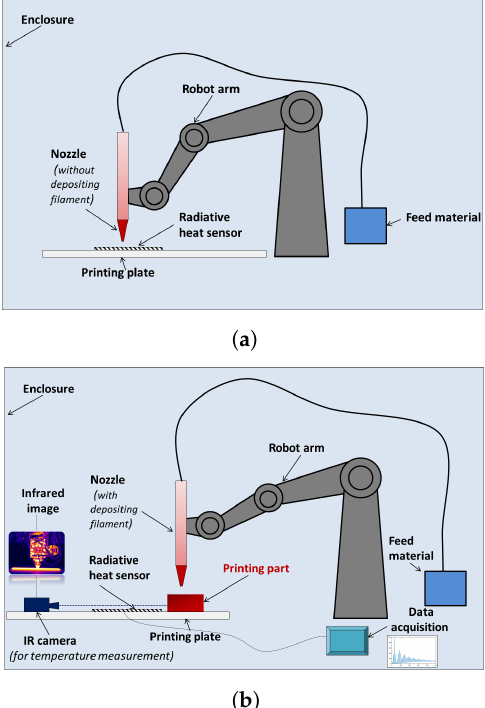
Figure 2. Experimental setup for determining the amount of thermal radiation during extrusion- based AM processes: ( a ) radiative calibration of the extruder with nozzle over the IR sensor without polymer extrusion, ( b ) infrared measurement from part and extruder during polymer extrusion A complete monitoring of the AM process is proposed by using the radiative sensor and an IR camera. It is a IR camera (Flir CEDIP JADE) having a spectral response of 3.6 µ m– 5.1 µ m, a sub windowing of 320 pixels × 256 pixels InSb focal plane array (FPA), a 50 mm fixed focus lens and a manufacturer rated precision of ± 1%. A computer is connected to the camera for image grabbing and further data analysis with Altair software. This experiment is used to show the effect of self heating of AM parts and the effect of the extruder’s radiative heat flux on the temperature field evolution of the part during the process. The box described previously is used in this experiment. The investigations are focused on the temperature evolution of one of the four walls of the box (Figure 3). A simultaneous data recording of the heat flux and the temperature field is done.